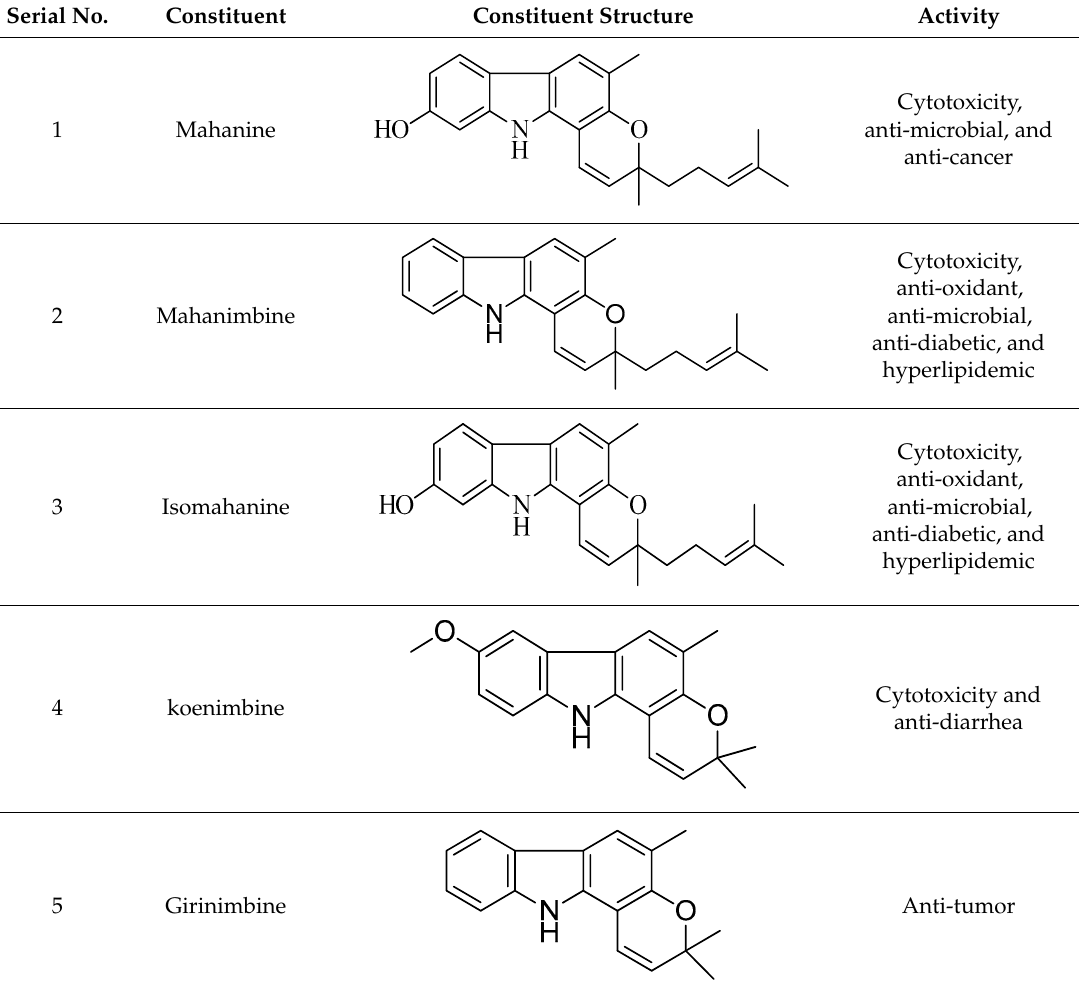
Table 2. The major bioactive compounds of M. koenigii and its pharmacological activities. Serial No.